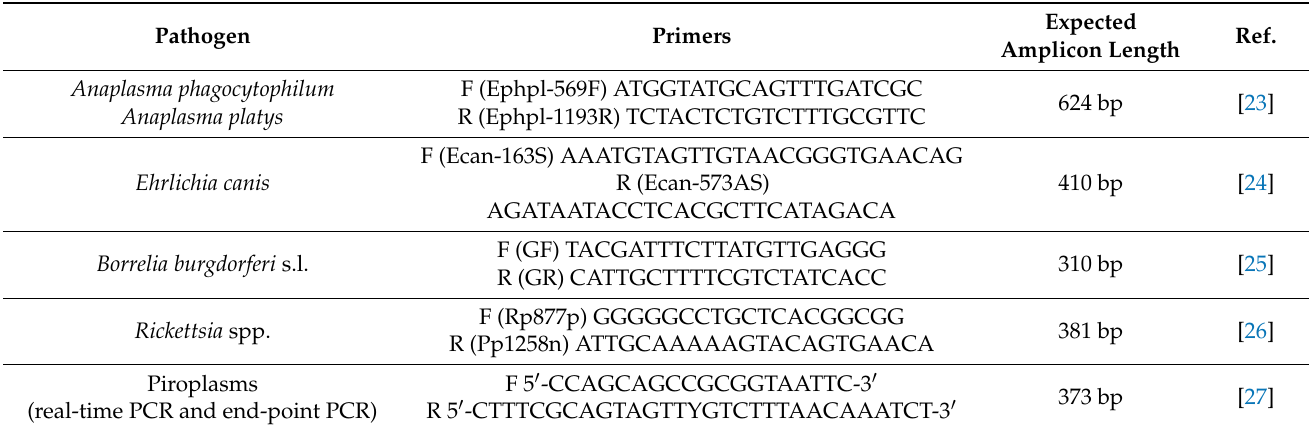
Table 1. Primers used in the analyses performed for the different pathogens targeted by the study and expected amplicon